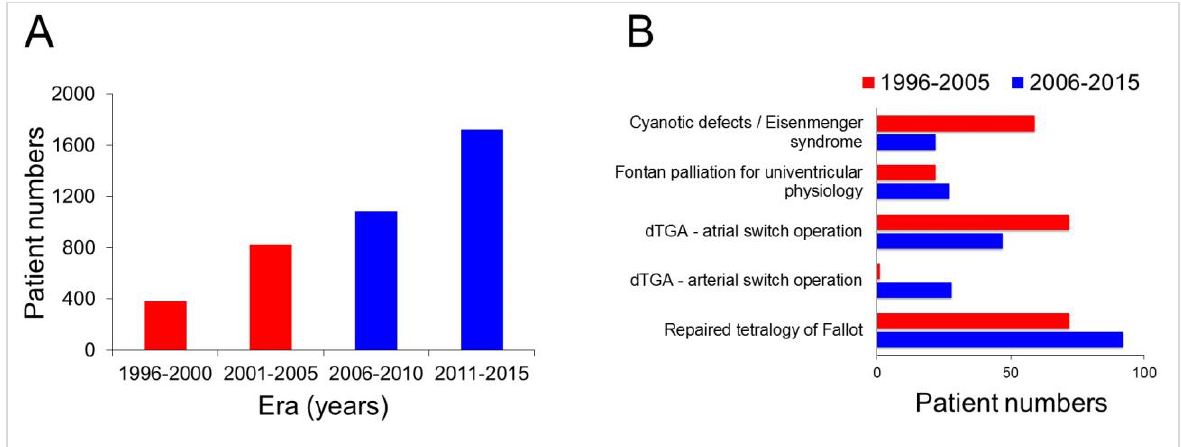
Figure 1: Evolution of patient numbers during the study period (red bars represent the first and blue bars the second decade of the study period). Panel A: Numbers of patients at the end of each 5-year era of the study period. Panel B: Comparison of newly referred patients with selected congenital heart defects, between the first and second decade of the study period. dTGA = d-transposition of the great arteries